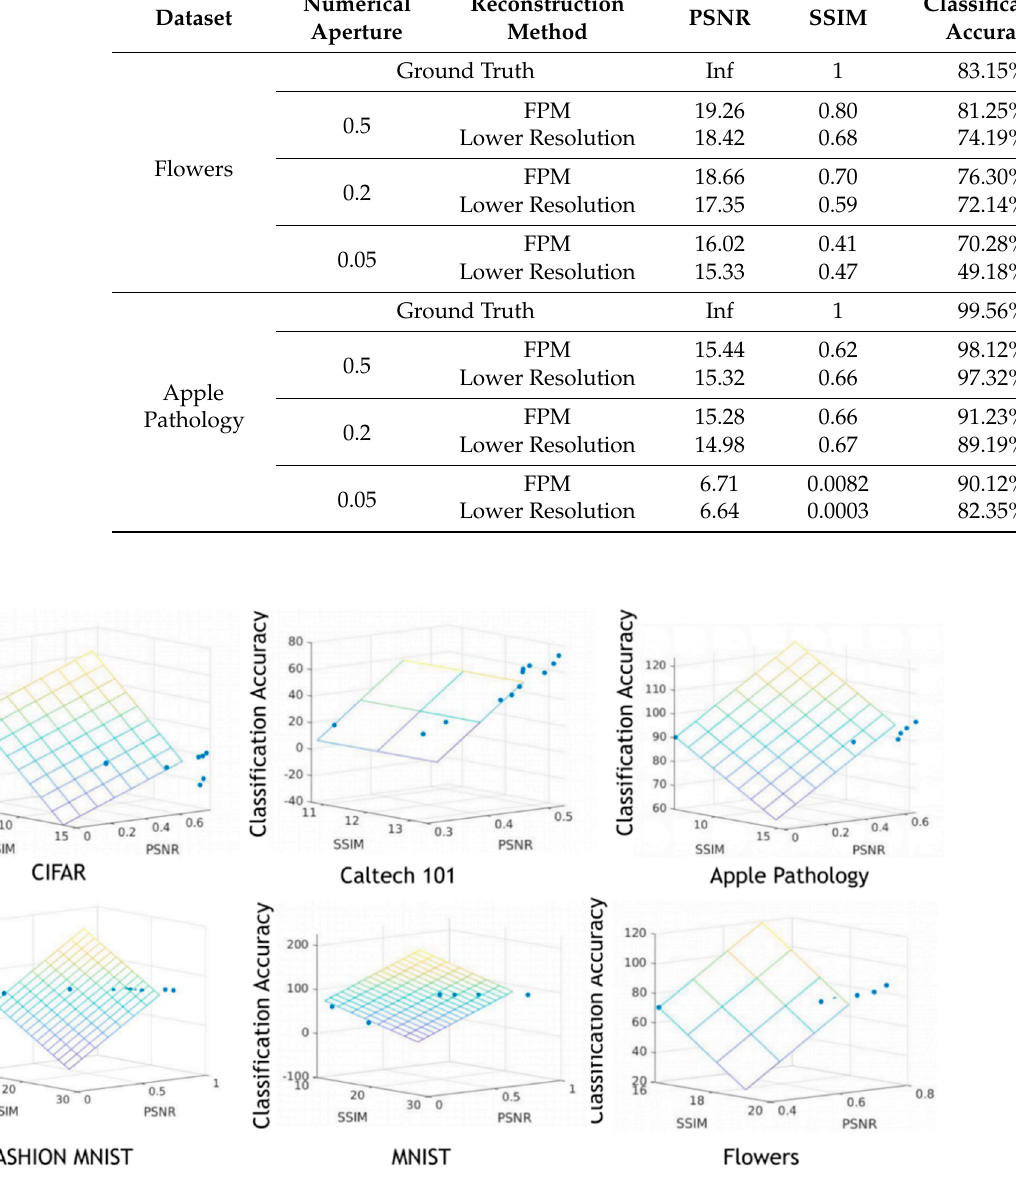
Figure 11. Visualization of data distribution for multiple linear regression between image classification accuracy, PSNR, and SSIM .